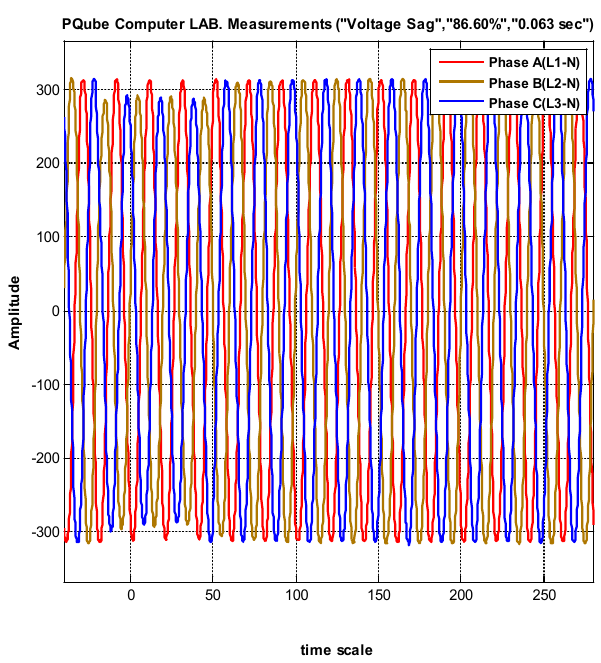
Fig. 8. After removing first imf voltage sag condition of